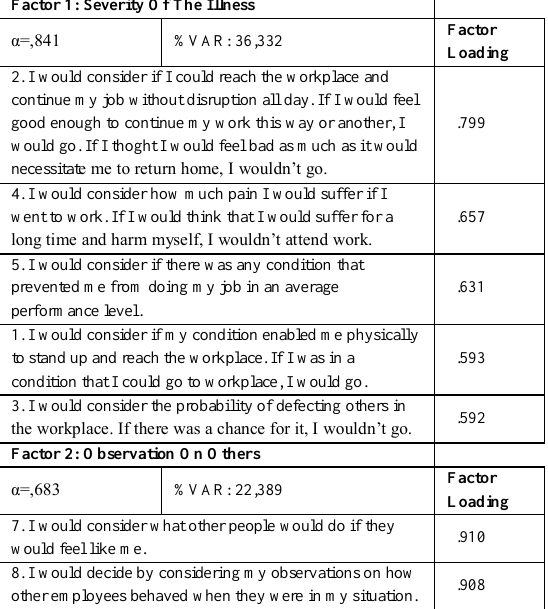
Table 14: Results of Exploratory Factor Analysis for Deciding Between Presenteeism and Absenteeism Factor 1: Severity Of The Illness